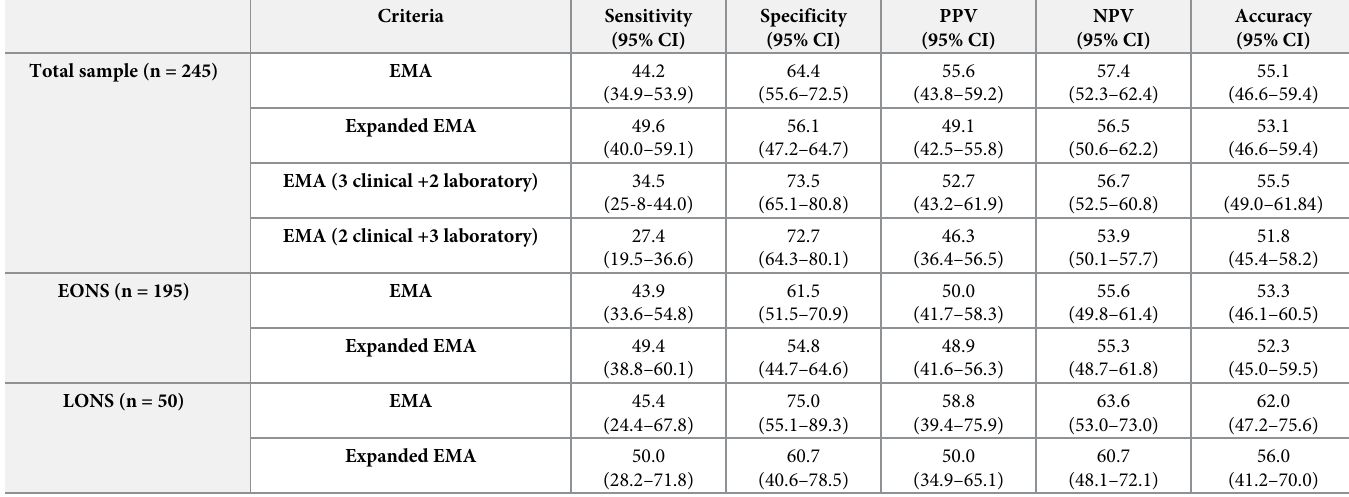
Table 3. Diagnostic accuracy measures a of EMA sepsis criteria and its modifications: In total sample and subgroups of EONS and LONS b